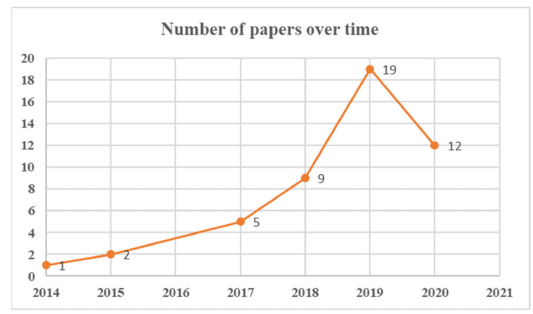
Figure 3. Distribution of papers over